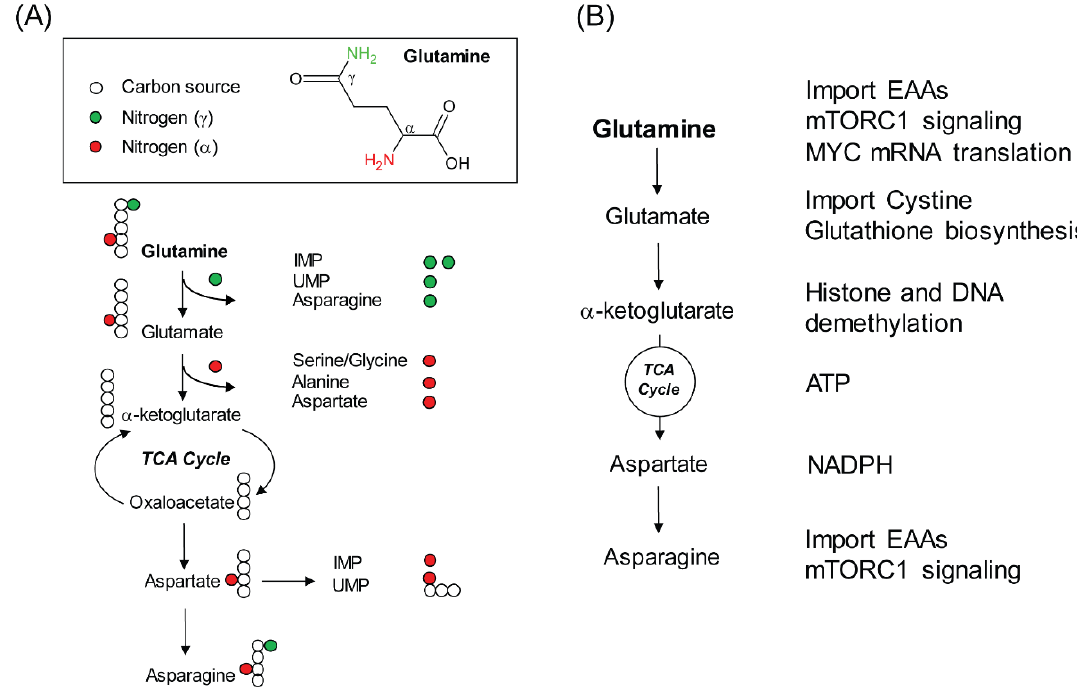
Figure 1. Glutamine catabolism and its cellular functions. ( A ) Utilization of glutamine-derived carbon and nitrogen atoms for the synthesis of nucleotides and NEAAs. The chemical structure of glutamine is illustrated at the top. This diagram highlights the contribution of carbon and nitrogen atoms from glutamine or its catabolic products to nucleotides and NEAAs. The biosynthesis of proline and arginine can also be derived from glutamate, but is not illustrated here due to the space limitation. Both amino acids use the entire five carbon atoms and one nitrogen atom of glutamate as their backbones. The biosynthesis of arginine acquires three additional nitrogen atoms. One is derived from glutamate, another one is derived from aspartate and the last one is derived from free ammonium. However, de novo biosynthesis of arginine is not considered to be the standard route of arginine acquisition, because several key enzymes in the urea cycle, which is indispensable for arginine production, are silenced in most cancers [19 – 22]. As a result, arginine is thought to be a conditionally essential amino acid. In addition, the -nitrogen of glutamine is also used for the de novo synthesis of GMP from XMP, CTP from UTP, NAD and glucosamine, which are not illustrated in the diagram. ( B )